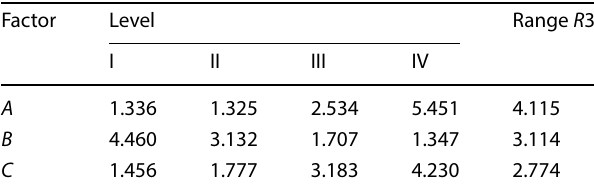
Table 5 Range analysis table for the float amplitude response oper- ator from the orthogonal